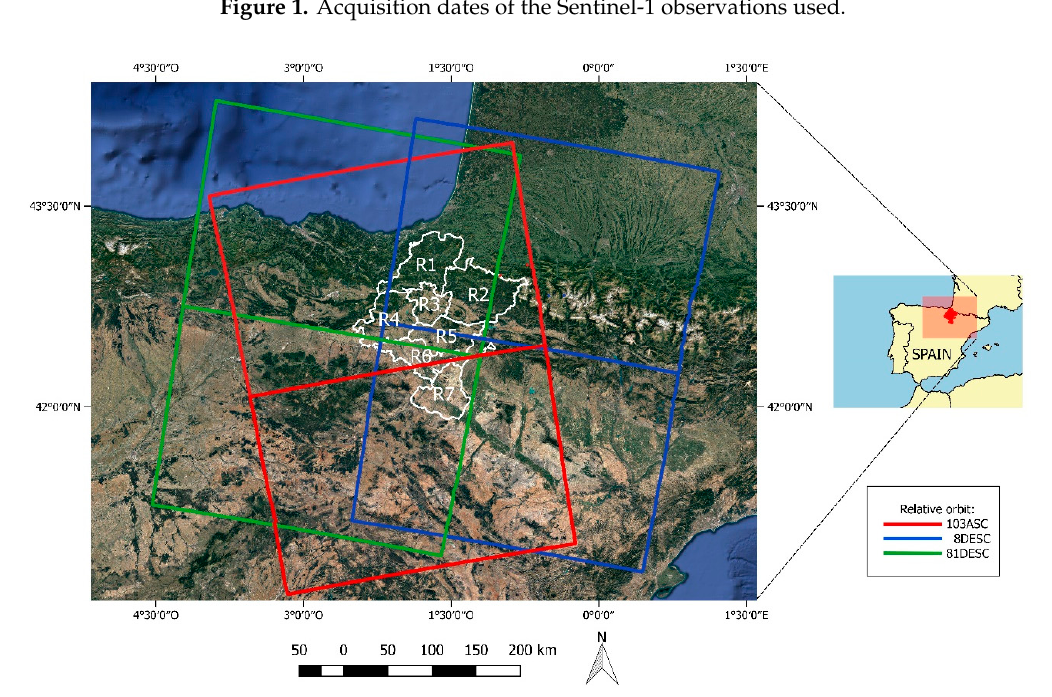
Figure 2. Location of the province of Navarre and its seven agricultural regions (in white, R1–R7) in Northern Spain superposed to the Google base map. The rectangles represent the footprints of the different relative orbits of Sentinel-1 covering Navarre.